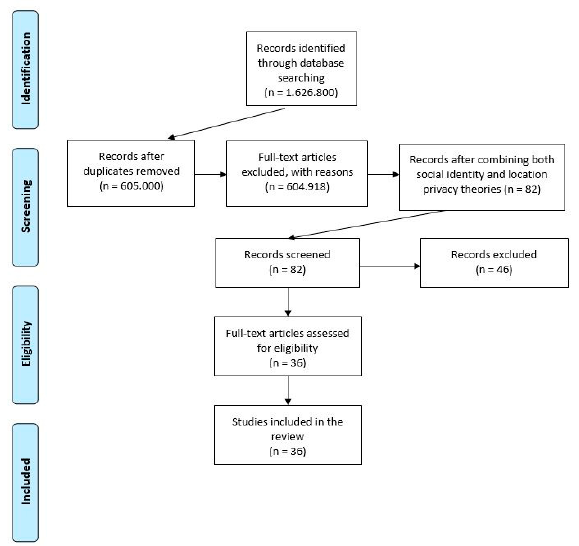
Figure 1. Methodology processes under Prisma 2009 flow diagram.